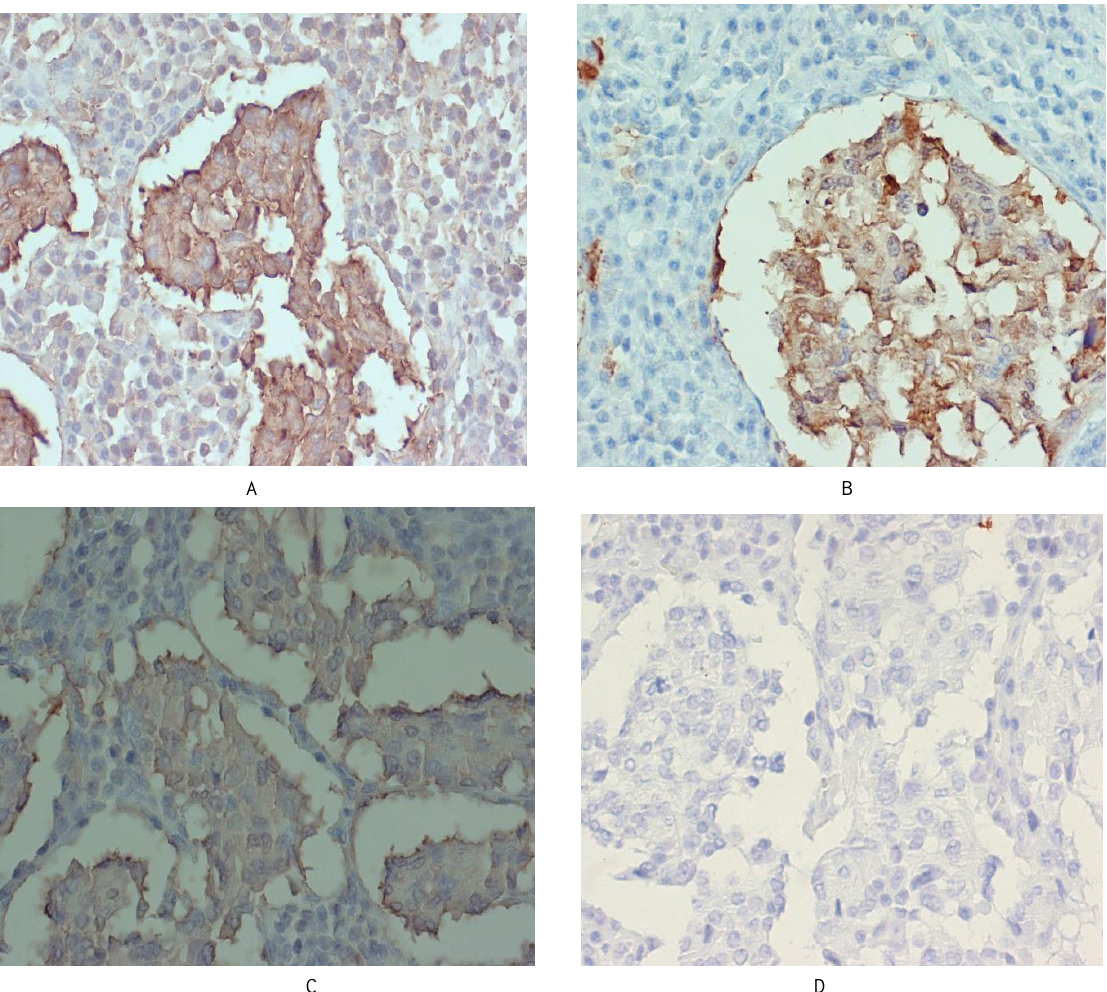
Fig. 3. A. P ositive immunoreaction for chromogranin; B. synaptophysin; C. S100 protein in peripheral sustanticular cells; D. S100 protein in peripheral sustanticular cells with negative reaction for cytokeratin